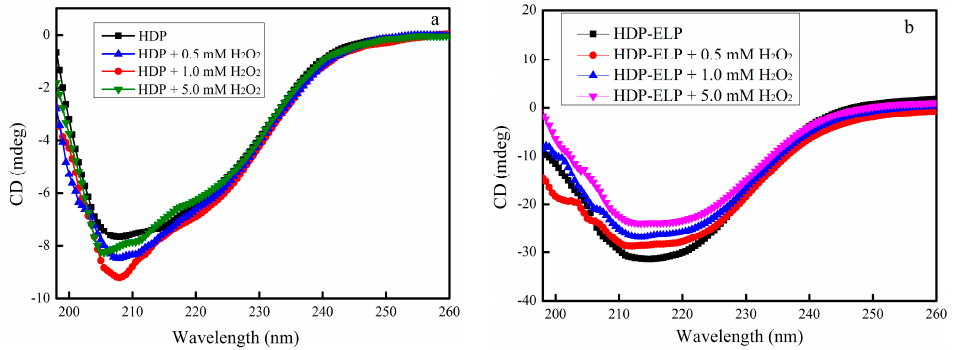
Figure 4. Effect of H 2 O 2 concentration on the secondary structures monitored by circular dichroism spectra. ( a ) HDP; ( b ) HDP ‐ ELP.